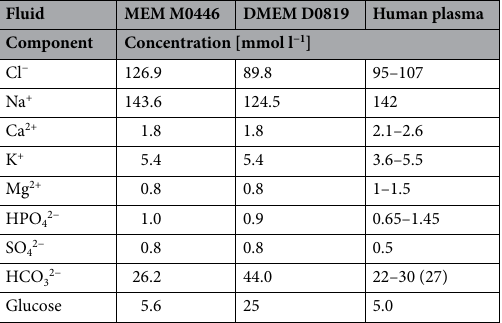
Table 3. Ionic composition and glucose concentration of cultivation media in comparison with human